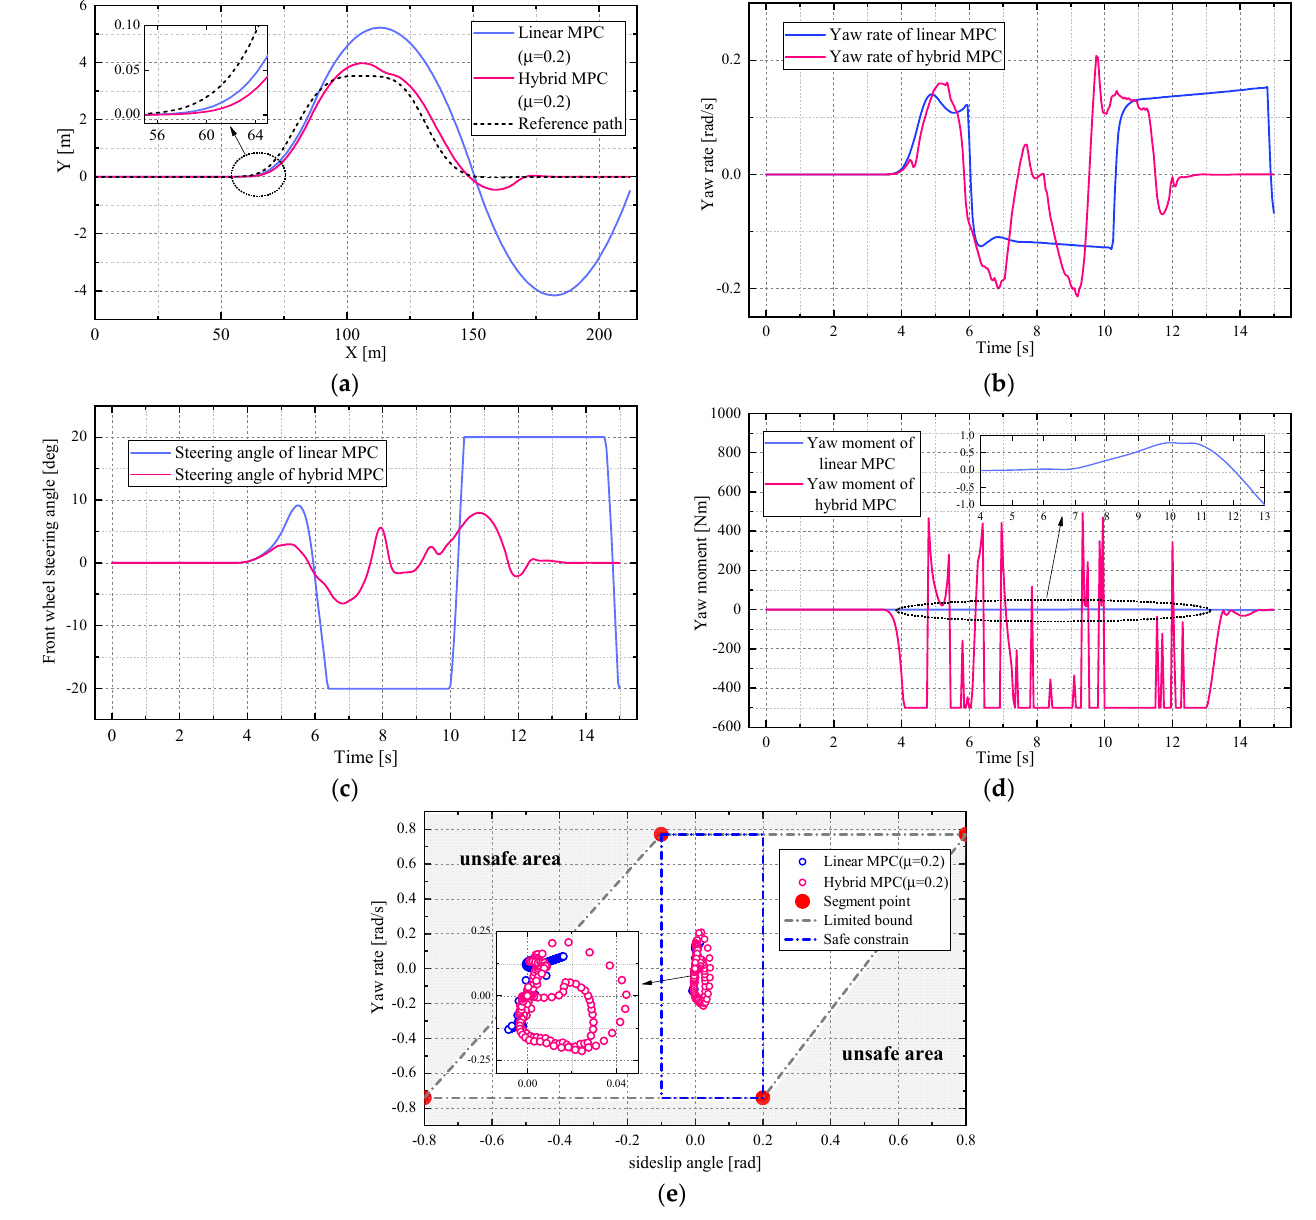
Table 2. Comparison of tracking errors and computing time of two methods.